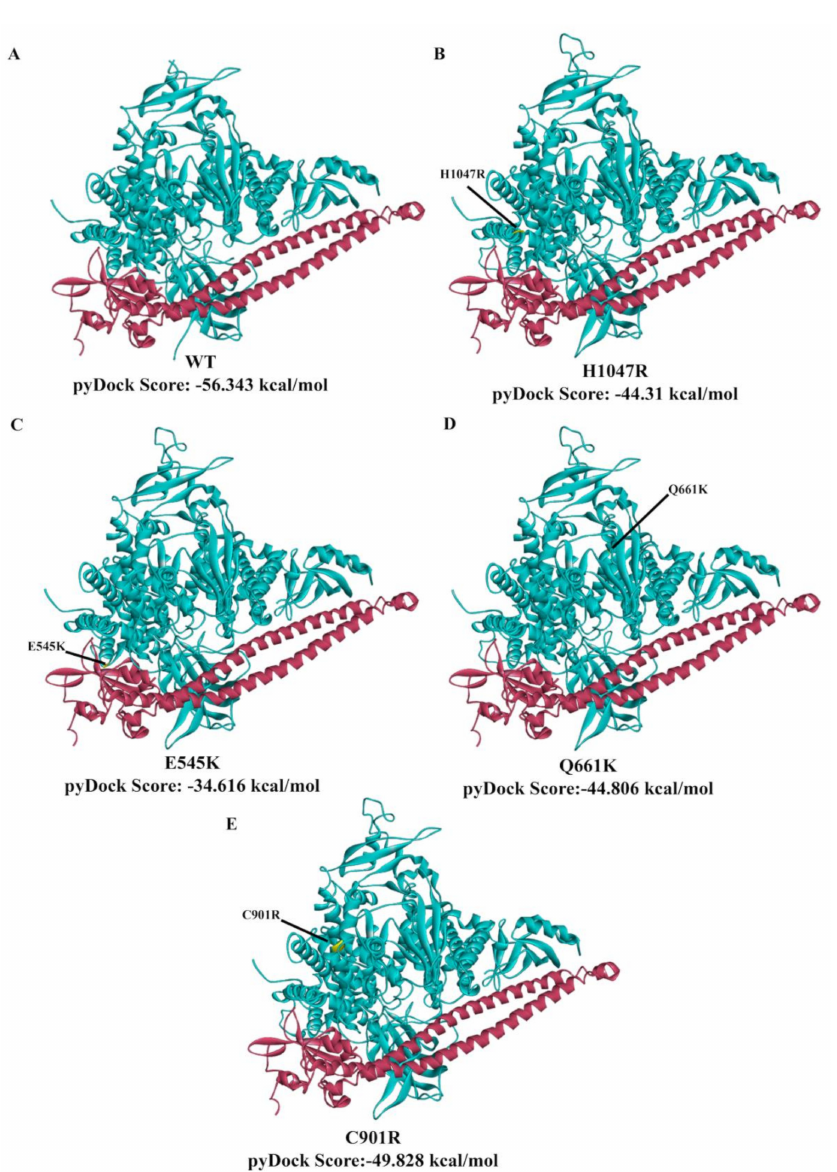
Figure 7. Simulated interactions of niSH2 domain of p85 alpha to wild type and mutant PIK3CA yielded variable binding energies. The solved X-ray crystal structure of human wild type PI3KCA ( A ) PDB 4L1B was used to build mutant homologues of ( B ) H1047R, ( C ) E545K, ( D ) Q661K, and ( E ) C901R. The pose with the most favorable and lowest (i.e., most negative) pyDock score is shown for each interaction. The mutated amino acid is highlighted in yellow and labelled accordingly. WT: wild type; PIK3CA: phosphatidylinositol 3-kinase, catalytic subunit